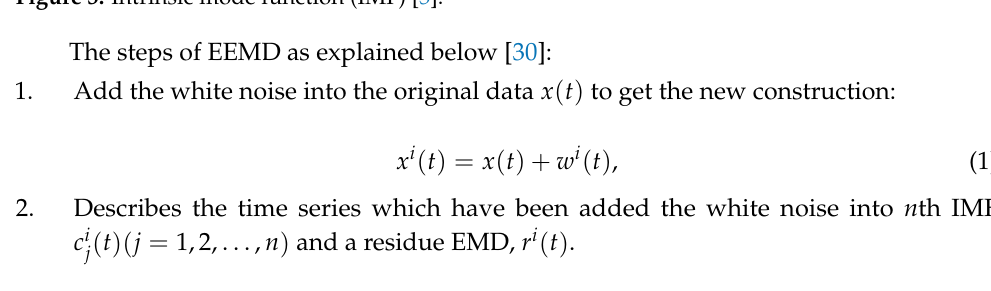
Figure 3. Intrinsic mode function (IMF) [5].